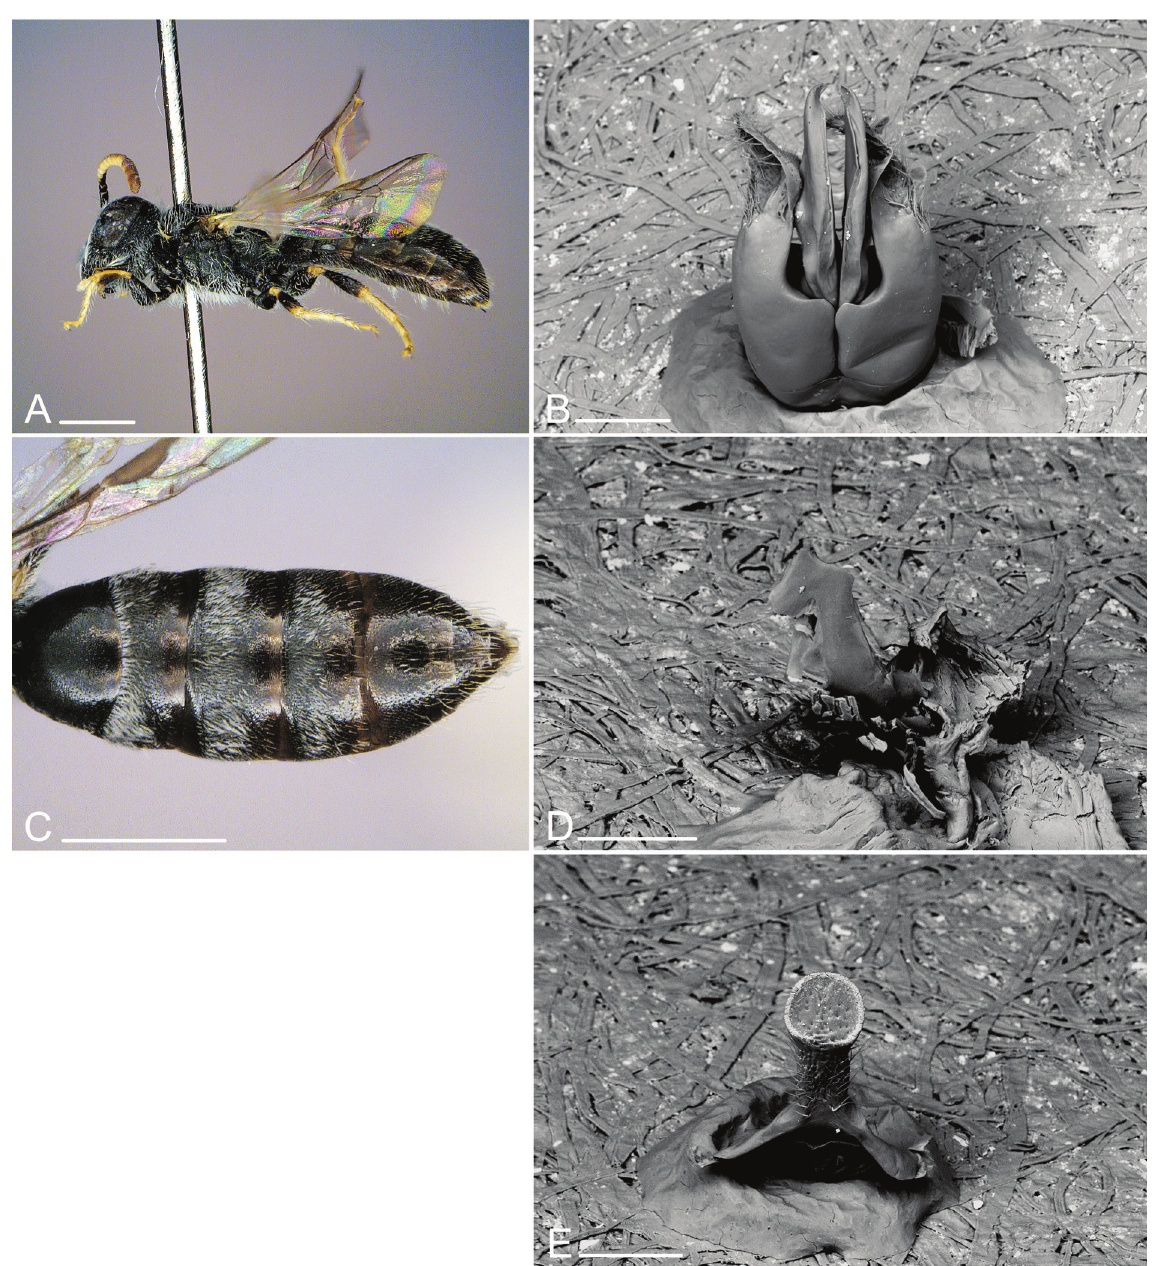
Fig. 13. Scrapter minutissimus sp. nov., ♂. A . Lateral view. B . Genitalia (dorsal view, SEM). C . Metasoma (dorsal view). D . S7 (dorsal view), left half missing (SEM). E . S8, apical end (SEM). Scale bars: photos: 1 mm, SEM: 0.1